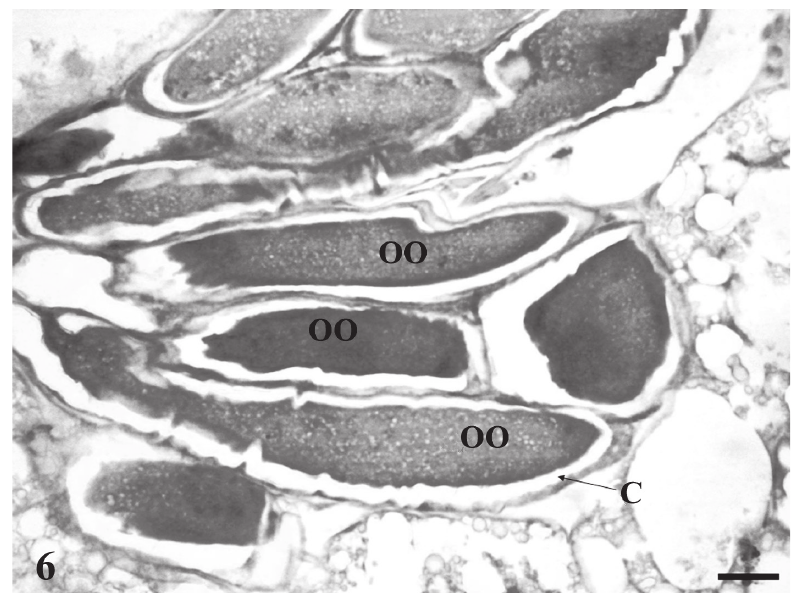
Figure 4 - Mature oocytes (OO) of females of Palmistichus elaeisis (Hymenoptera: Eulophidae) 24 h after their emergence from Tenebrio molitor (Coleoptera: Tenebrionidae) pupae. C - chorion. Bar: 10µm.